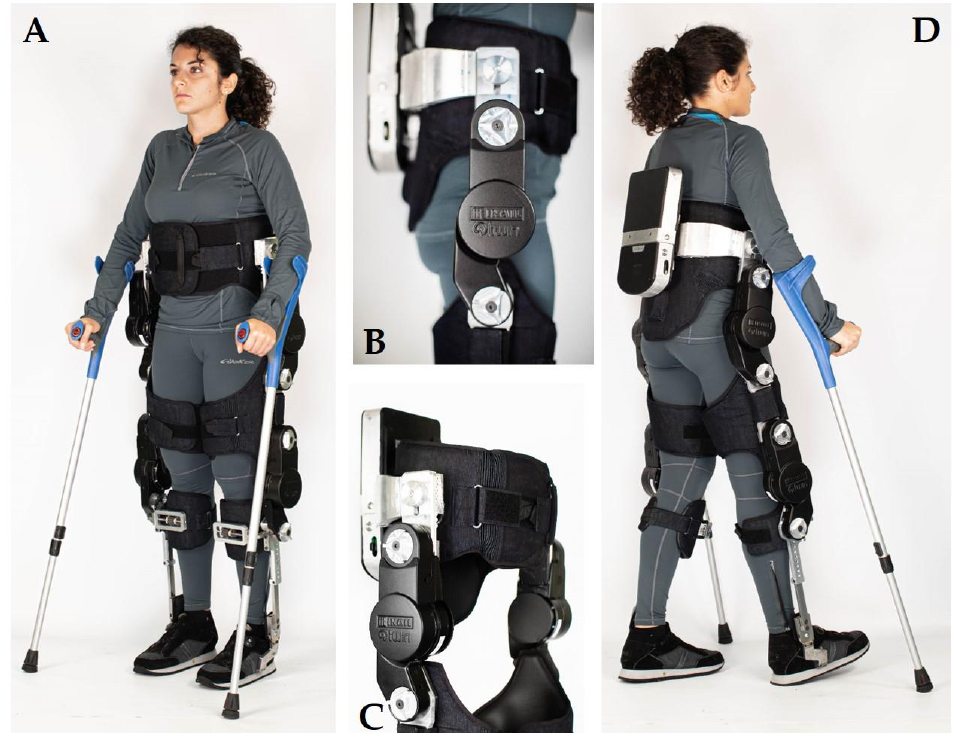
Figure 2. Fronto-lateral view of the Twin exoskeleton ( A ), lateral view ( B ) with a particular focus on the hip joint (motor and electromechanical interface), fronto-lateral view ( C ) of the pelvis module highlighting the pelvis structural element and the backpack containing the battery, and posterior view ( D ). Written informed consent was obtained from the subject depicted in the panels.